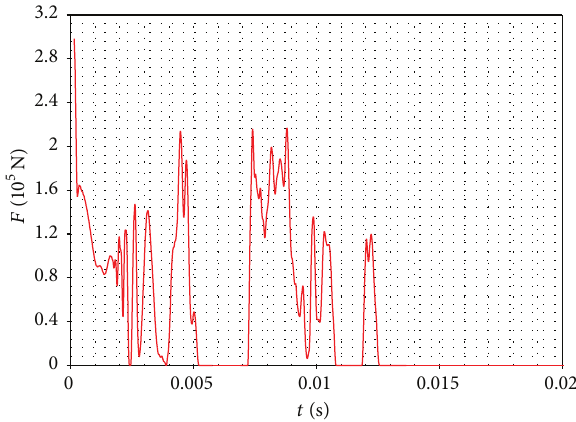
Figure 4: Impact force variation in case of load mishandling. Mass 3200 kg, velocity 0.4